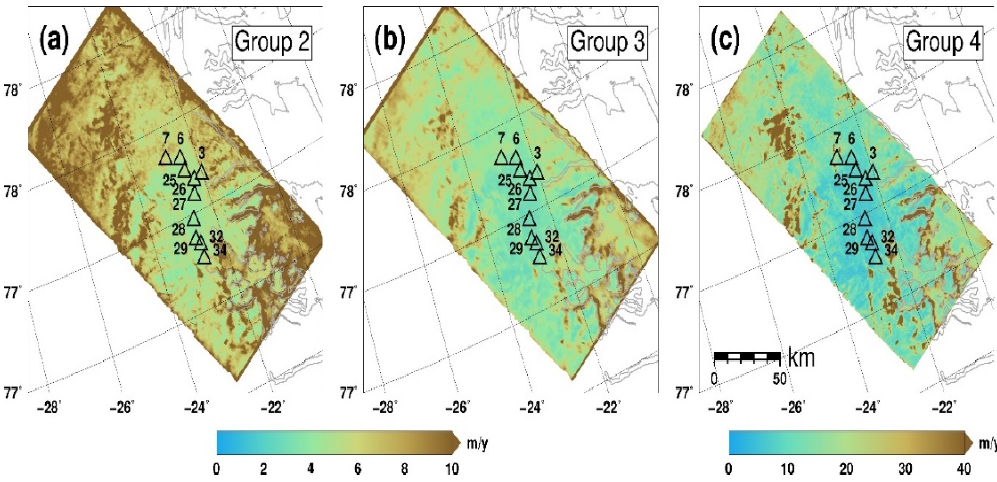
Figure 7. Task 2 azimuth quality parameters provided by groups 2 ( a ); 3 ( b ); and 4 ( c ). For all groups the quality parameter is the predicted azimuth velocity error standard deviation in m/y. Triangles represent the GPS stations used for validation.